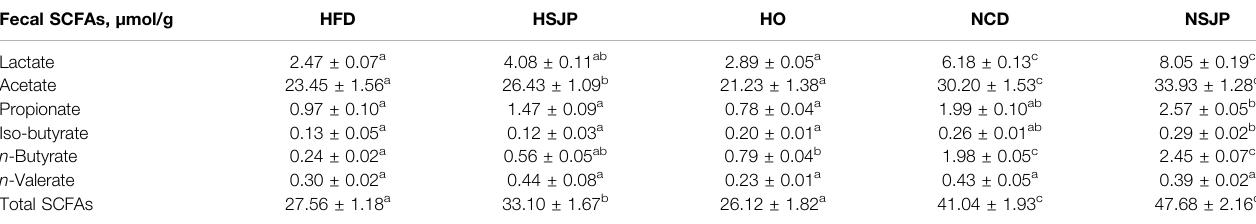
TABLE 2 | Fecal SCFAs in HFD-fed C57BL/6 mice supplemented with SJP. Fecal SCFAs, μ mol/g